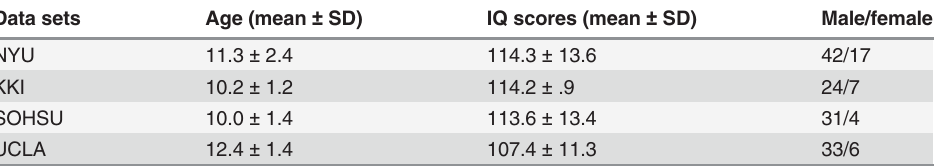
Table 1. Demographic characteristics of the used subjects. For age and IQ scores, we show the mean and corresponding standard deviations (SD).